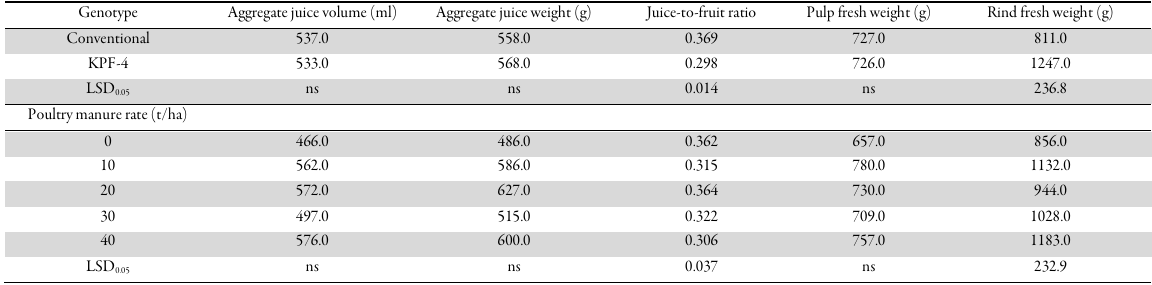
Table 6. Main effects of genotype and poultry manure rates on juice metric traits of yellow passion fruit grown in the field in 2015